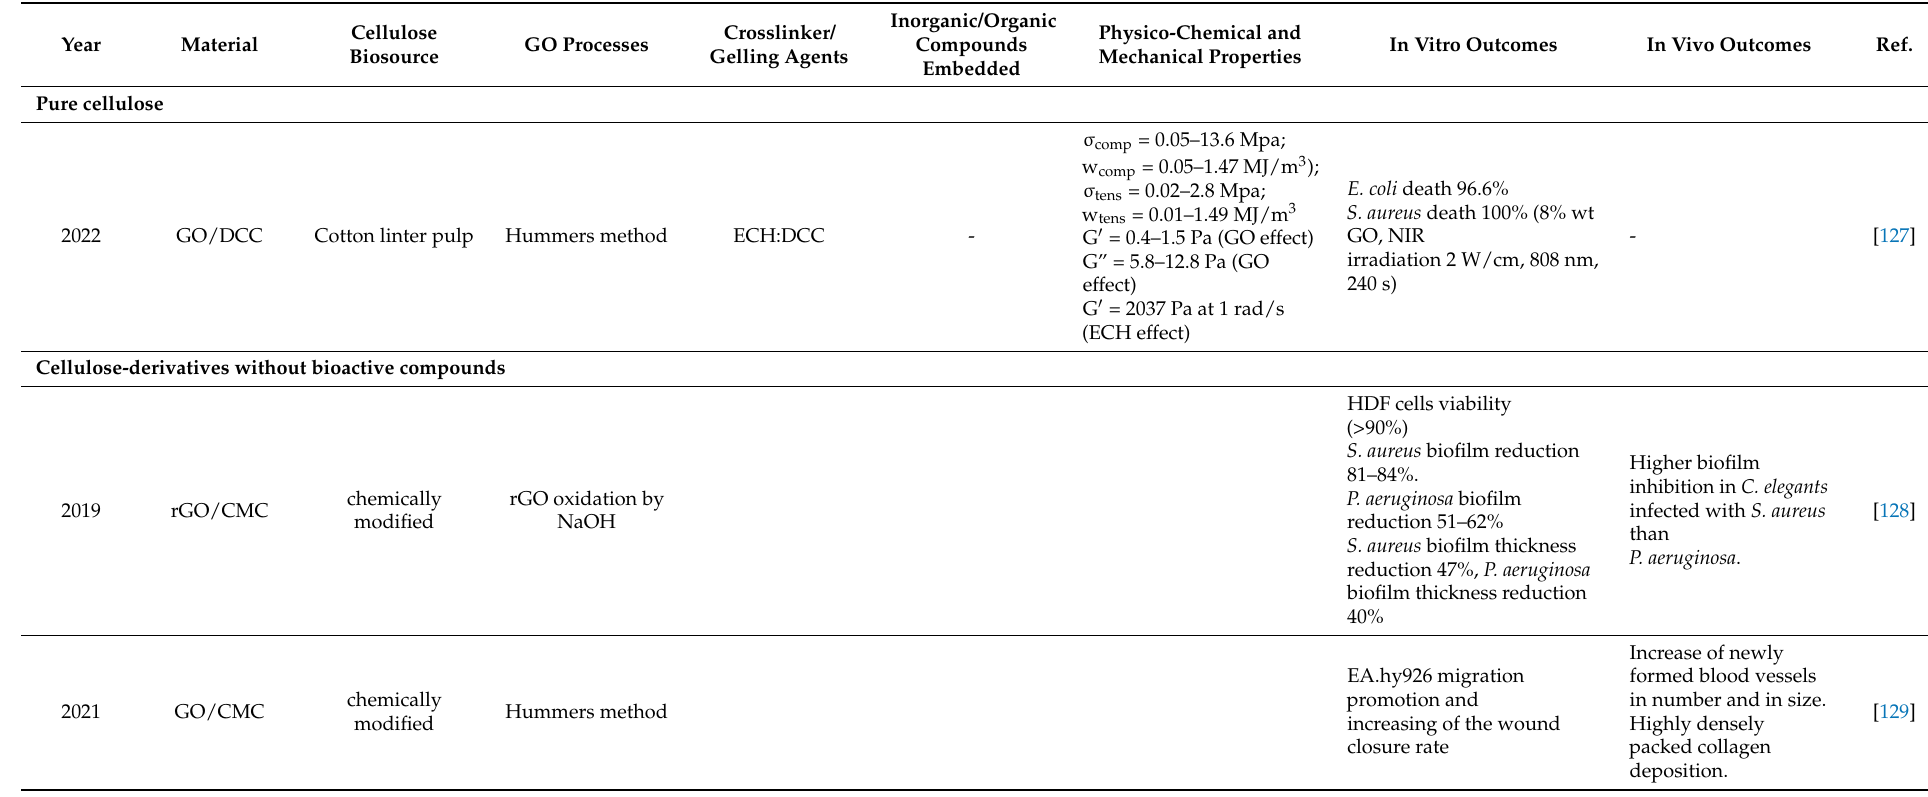
Table 4. List of the papers focused on pure cellulose and derivatives based composites functionalised with GO(rGO) for wound healing